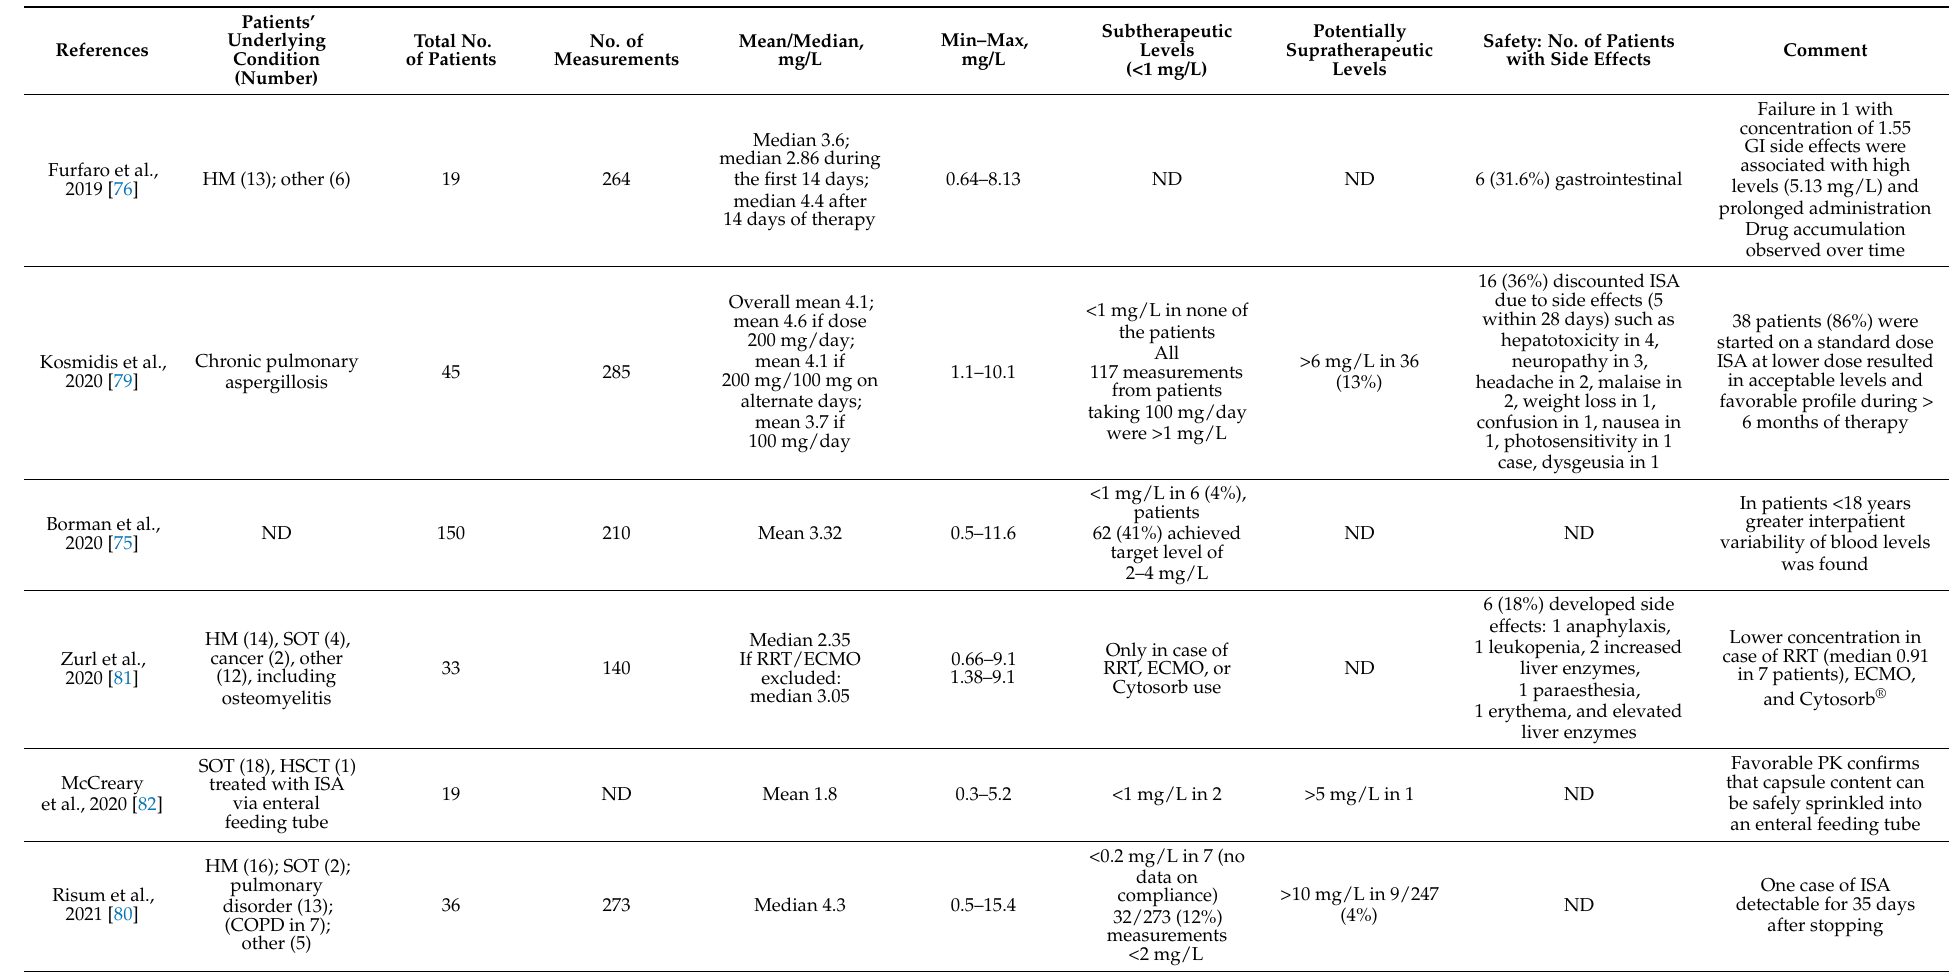
Table 4. Main studies reporting the experience with TDM of